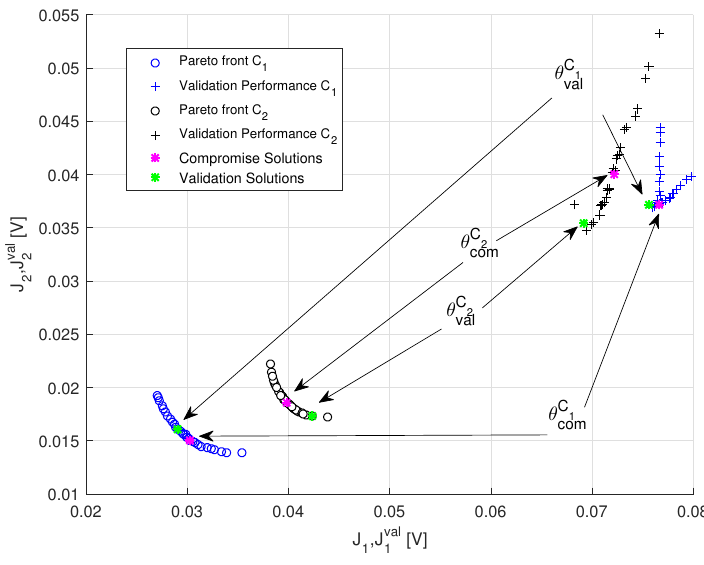
Figure 14. Pareto solutions obtained from the identification data and their performances in the validation test. The compromise and validation solutions are highlighted.